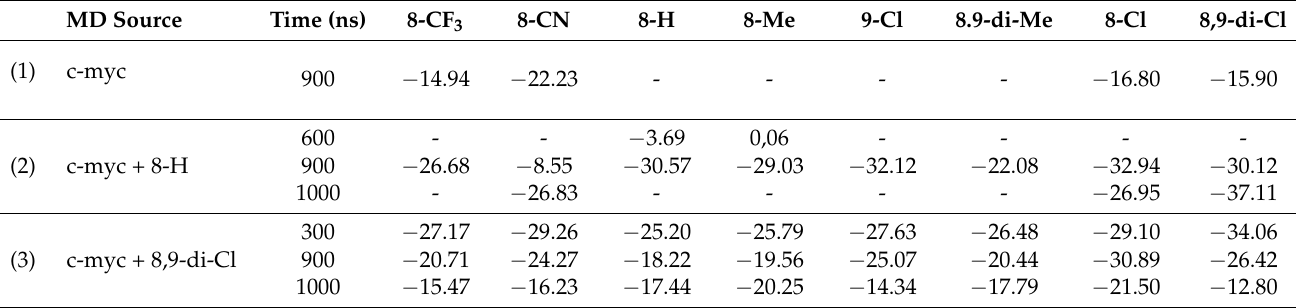
Table 4. Prime MMGBSA dG bind values expressed in kcal/mol on the G-quadruplex conformations extracted from the Molecular Dynamics simulations of c-myc at 350 K, or its complexes with the ligand 8-H or 8,9-di-Cl. A “-” sign indicates that no pose was